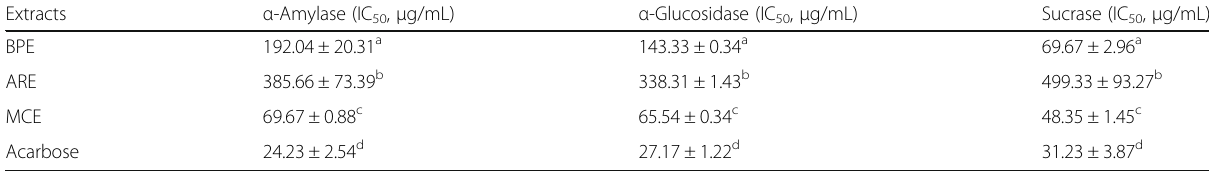
Table 1 Carbohydrate-digesting enzyme inhibitory potentials of the extracts of dried leaves of C. alata Extracts